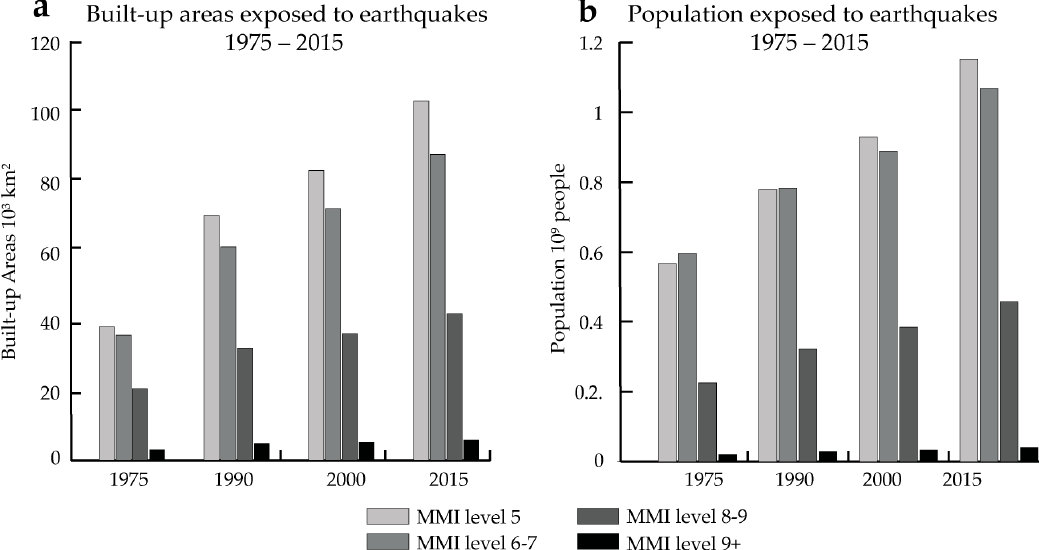
Figure 4. Built-up area ( a ) and population ( b ) in areas potentially affected by earthquakes of magnitude 5 and above based on a 475 probabilistic earthquake shaking intensity map measured in Modified Mercalli Intensity (MMI) scale.